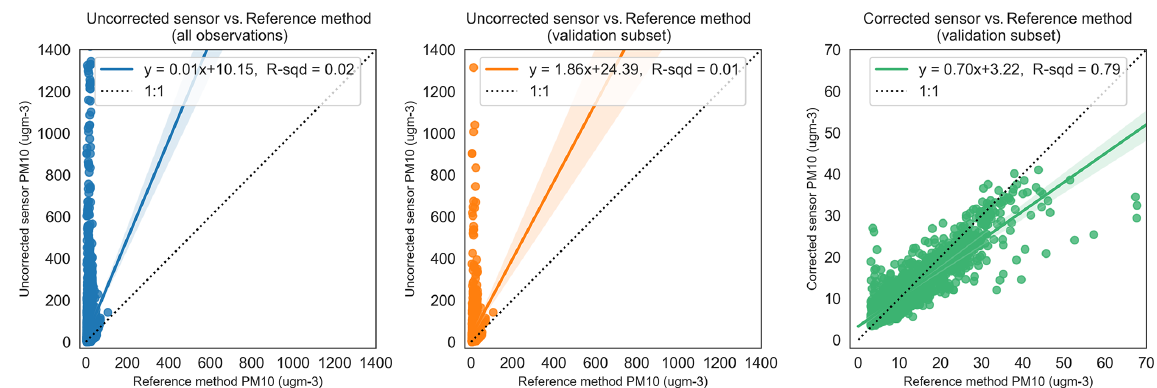
Figure 7. Relationship between uncorrected sensor, RF-model-corrected sensor and reference method observations for PM 10 . The dotted line shows the unity slope. R-sqd: R 2 . ugm-3: µgm − 3 .